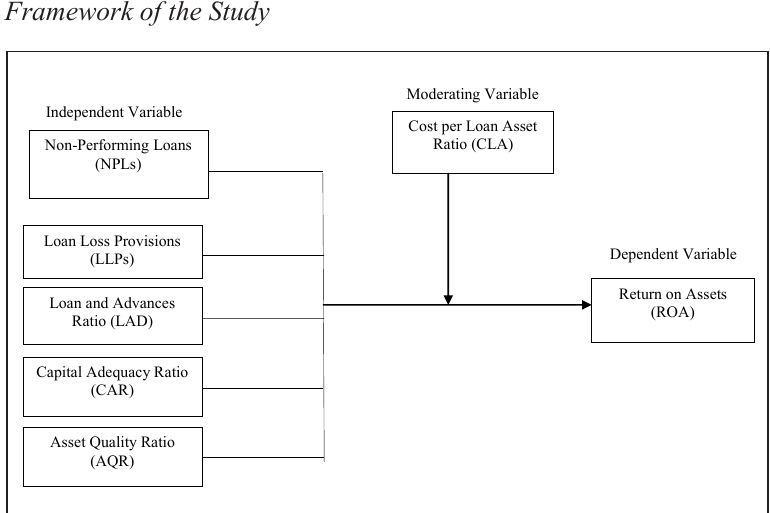
Framework of the